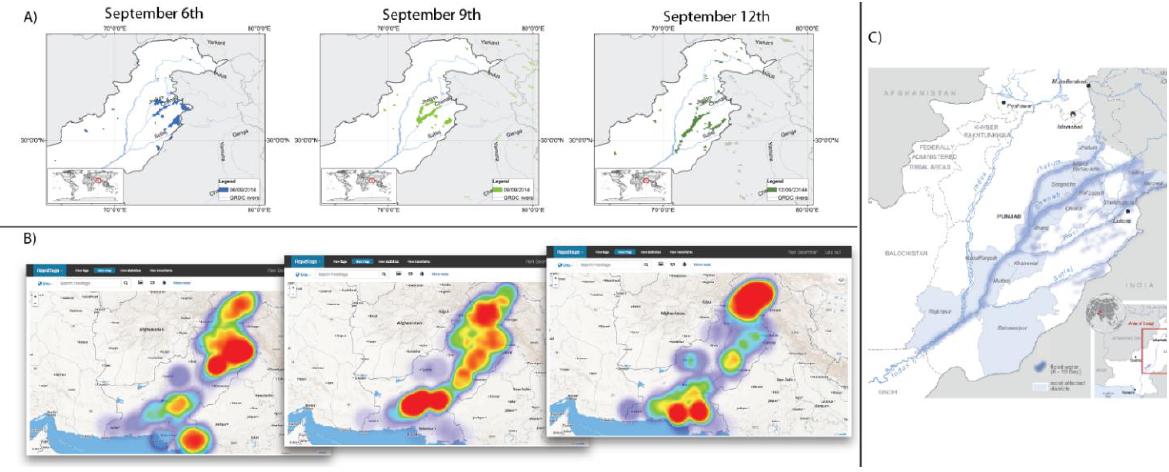
Figure 2. Affected flood areas as derived from different sources: ( A ) flood signal from GFDS for 6, 9 and 12 September. ( B ) heat map based on flood related Twitter activity for 6, 9 and 12 September; and ( C ) inundation map published by UN-OCHA in October